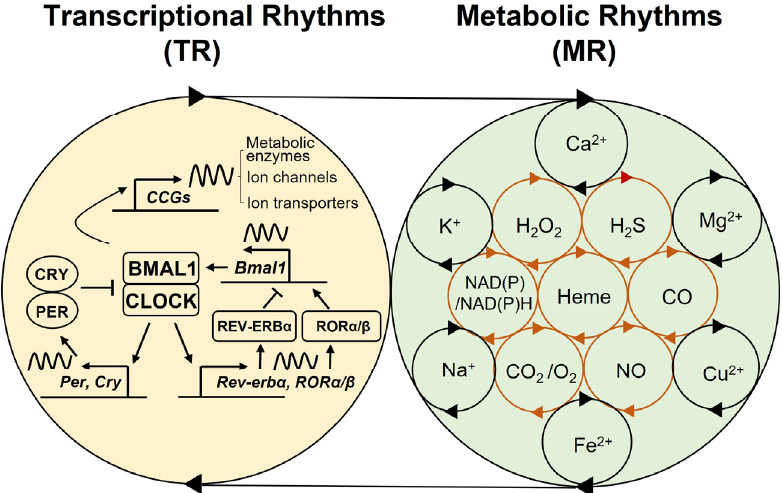
Figure 1. Coupled-cellular oscillators. Bidirectional regulation between transcriptional and metabolic rhythms. The auto-regulatory feedback cycles between the CLOCK/BMAL1 transcriptional activator complex and its transcriptional repressors (PER/CRY, REV-ERB α ) and activators (ROR α / β ), constituting the molecular clock oscillator. This oscillator drives the expression of multiple clock-controlled genes (CCGs), such as metabolic enzymes, ion channels, and transporters. The transcriptional rhythms (TR) mediate metabolic rhythms (MR) involving the cyclic synthesis, degradation, and transport (e.g., influx/efflux) of redox factors, gases, and ions, which, in turn, provide feedback that regulates the TR, constituting coupled-cellular oscillators.